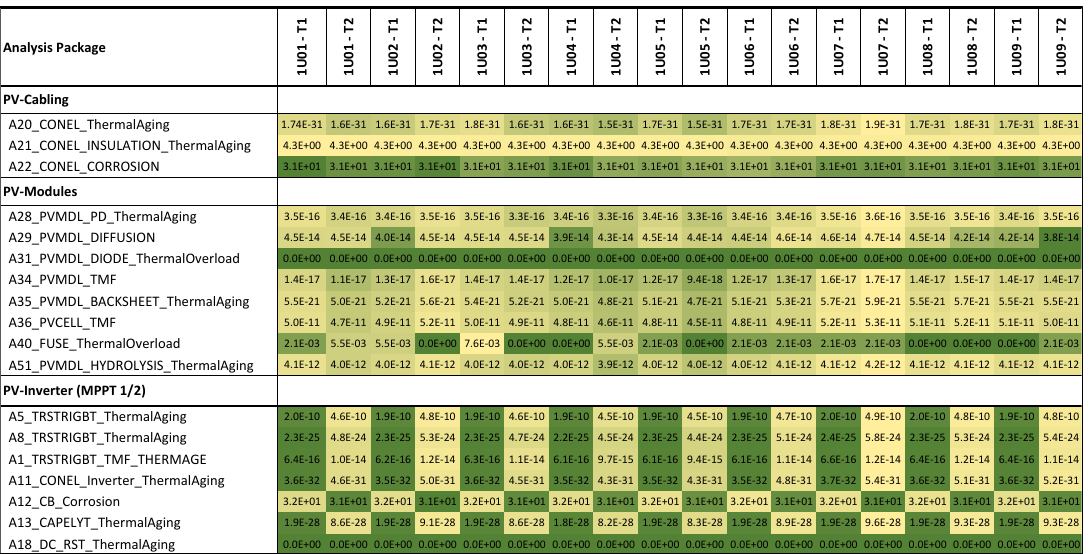
Figure A1. Damage calculation results for MPPTs “1U01 - T1”–“ 1U09- T2” .